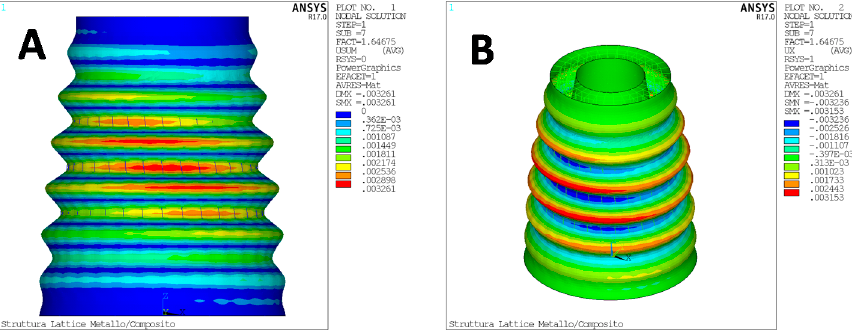
Figure 14. Test case 1—2nd buckling mode. ( A ) Total Displacement in Cartesian reference system; ( B ) radial displacement in cylindrical reference system.